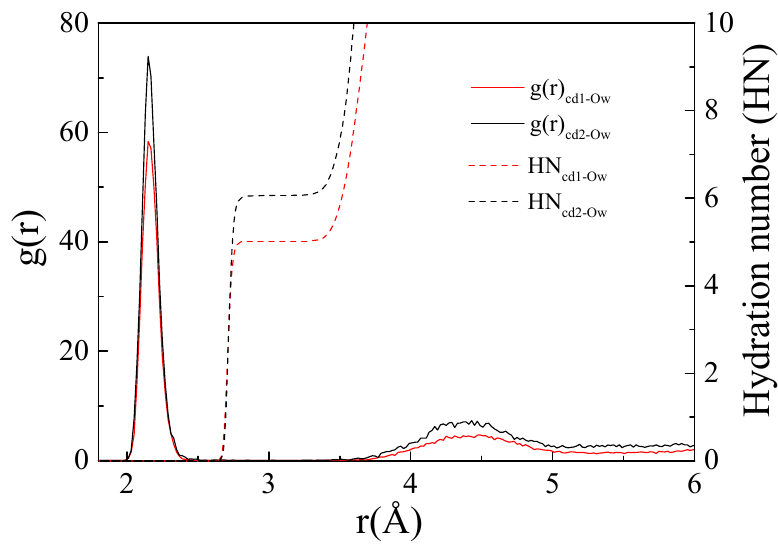
Figure 7. Cd-O w radial distribution.